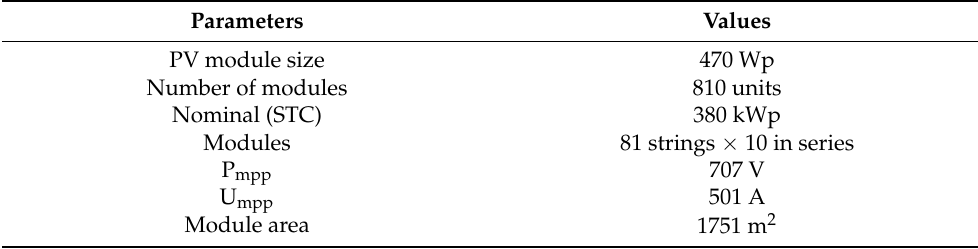
Table 5. PV module details.